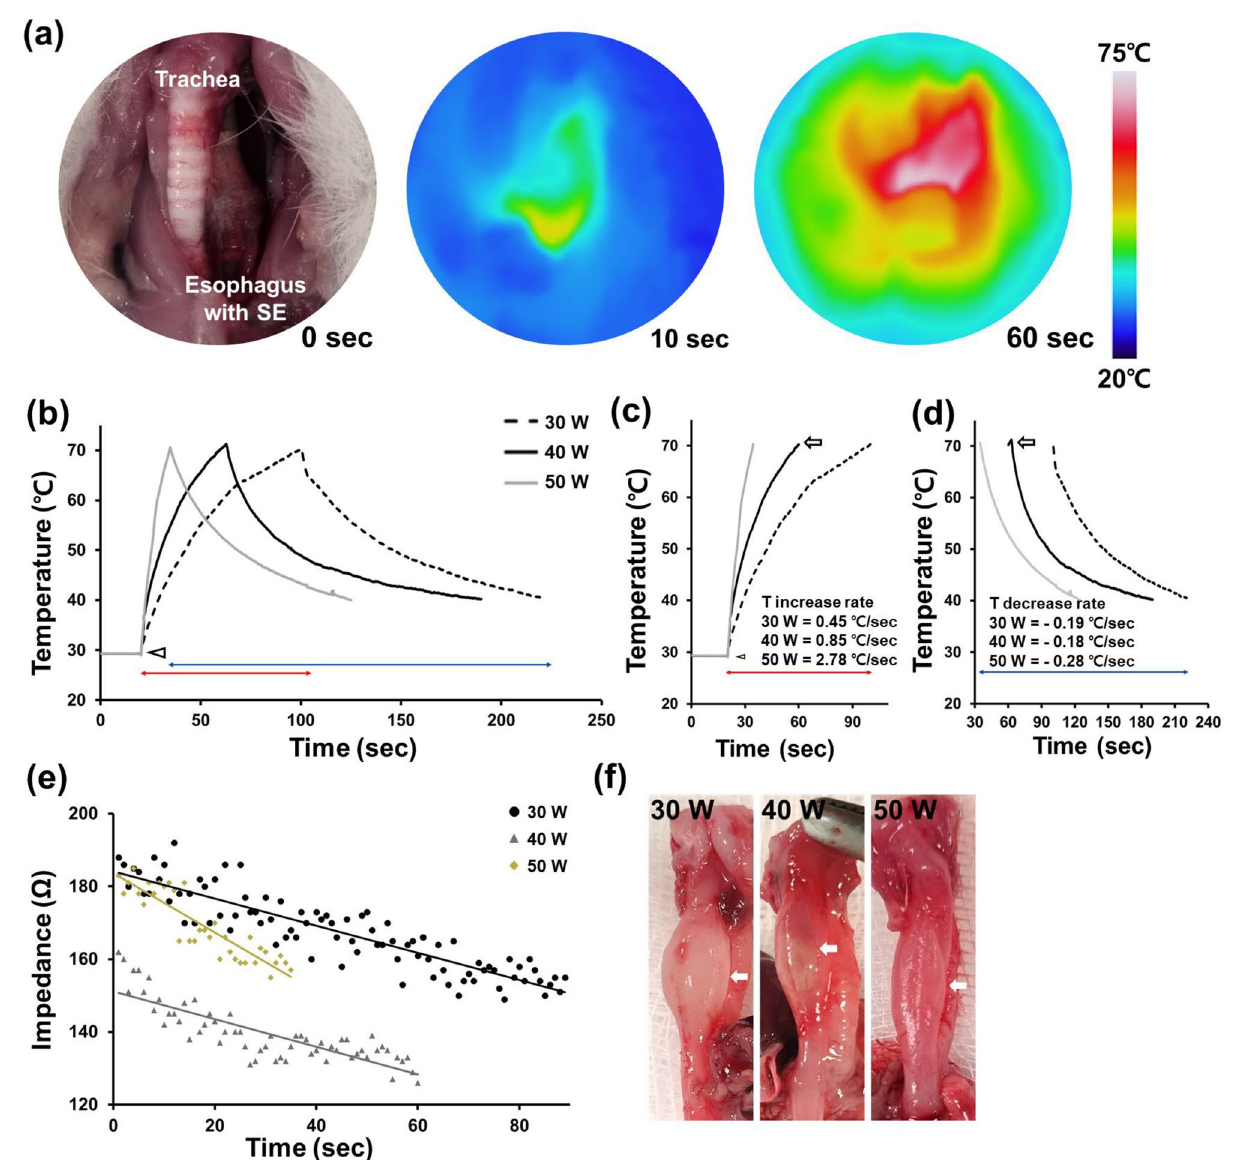
Figure 3. Temperature changes during radiofrequency (RF) ablation via the stent-based monopolar RF electrode (SE) in the rat esophagus. ( a ) Representative photographs and thermal images obtained during RF ablation of the rat esophagus through the SE at a 40 W power setting for 60 s. ( b ) Graph showing the recorded temperature changes during RF ablation at 30, 40 and 50 W. All RF energies were applied starting at the same time point ( arrowhead ) until the temperature reached 70 ℃ ( arrow ). ( c ) Initial heating temperature ( red line ). ( d ) Cooling temperature changes after the cessation of RF energy transfer ( blue line ). (e) Impedance profile changes during RF ablation in the exposed rat esophagus in accordance with different power settings at 30, 40, and 50 W. ( f ) Gross finding by various RF parameter in the extracted rat